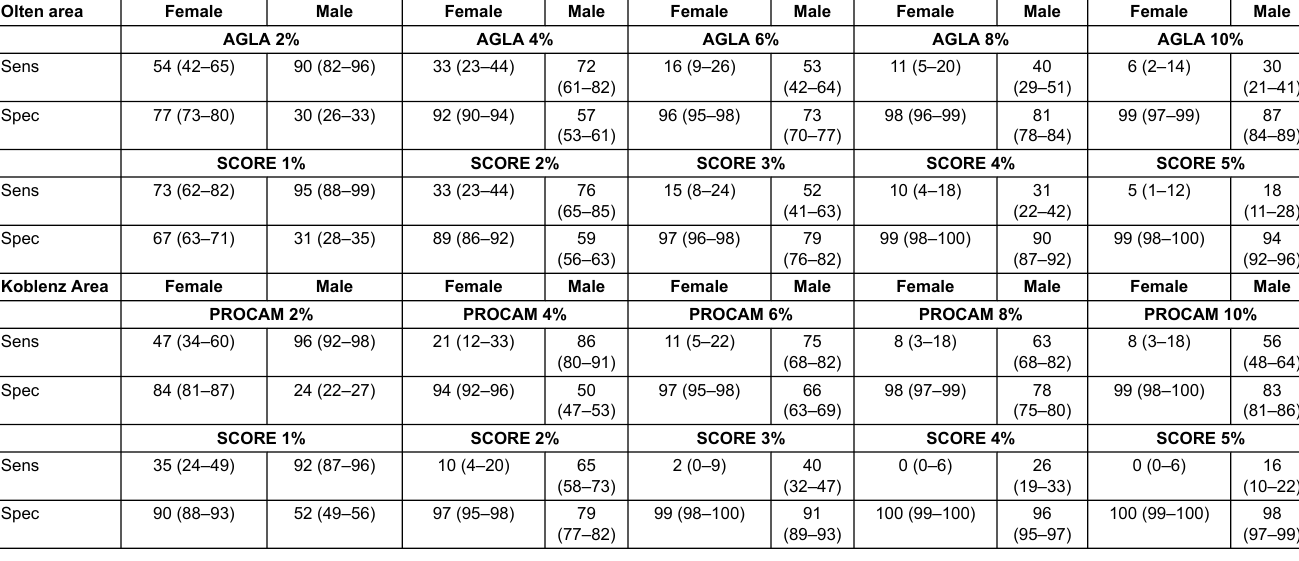
Table 4: Sensitivity (Sens) and specificity (Spec) of AGLA, PROCAM, and SCORE to detect VA70 at various decision cut-offs for female and male subjects from the Olten area and the Koblenz area including 95% confidence intervals (Note: AGLA = PROCAM × 0.7). Olten